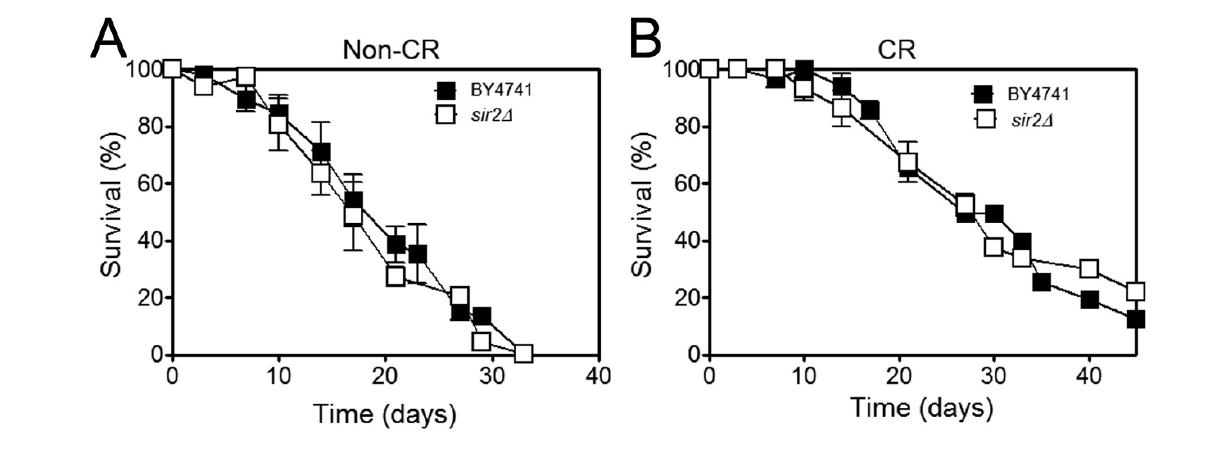
FIGURE 1: SIR2 deletion does not have a major impact on CLS either in normal growth conditions or under caloric restriction. Chronologi- cal lifespan of wild type (background BY4741) or sir2 D cells submitted to (A) non-caloric restriction (non-CR) or (B) caloric restriction (CR) conditions. All experiments were performed in synthetic complete (SC) medium containing yeast nitrogen base and glucose, as a carbon source, supplemented with the appropriate amino acids and bases. The concentration of glucose used was 2% in non-CR conditions or 0.5% to promote CR. Cells were incubated at 26°C with shaking at 150 rpm. Cultures reached stationary phase 2 days later and this was considered day 0 of CLS. Survival was assessed by counting colony-forming units (CFUs) beginning at day 0 of CLS (when viability was considered to be 100%), and then again every 2-3 days until less than 0.1% of the cells in the culture were viable. The data represent mean ± SEM of three biological independent replicas. No statistical significance was obtained between the CLS curves presented both in panel A and in panel B, as determined by two-way